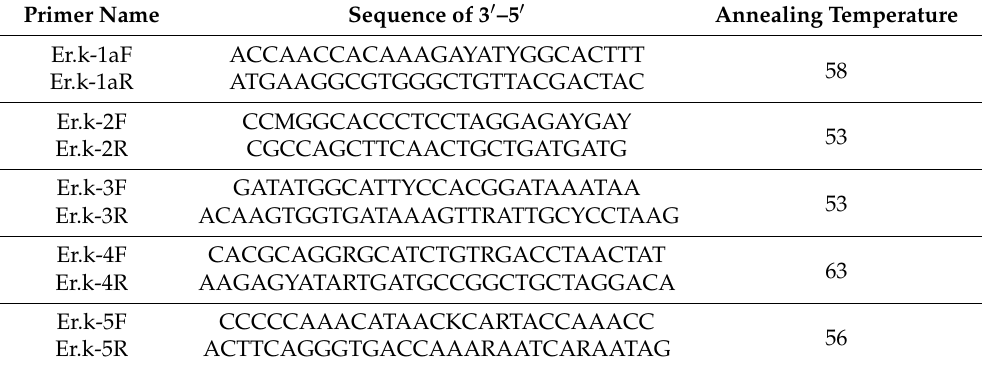
Table 2. Samples used in molecular